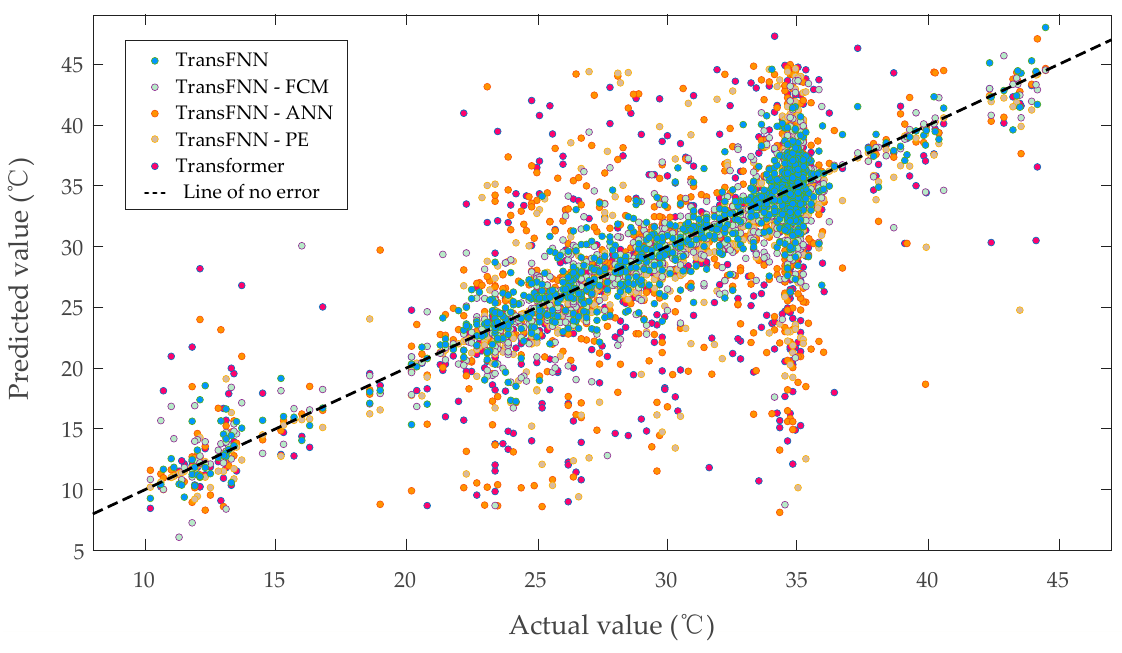
Figure 11. Sca tt erplot of the actual and predicted values. Figure 11. Scatterplot of the actual and predicted values.